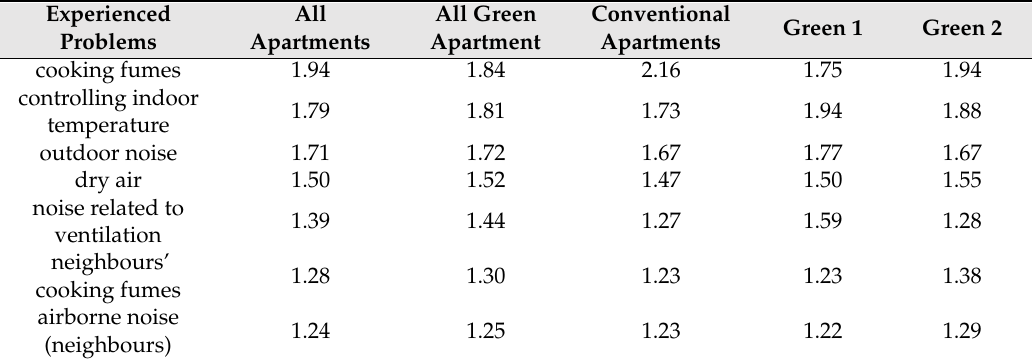
Table 9. Mean values for perceived frequency of experienced problems with IEQ, applied scale: 1 = no problem (never experienced), 2 = sometimes, 3 =